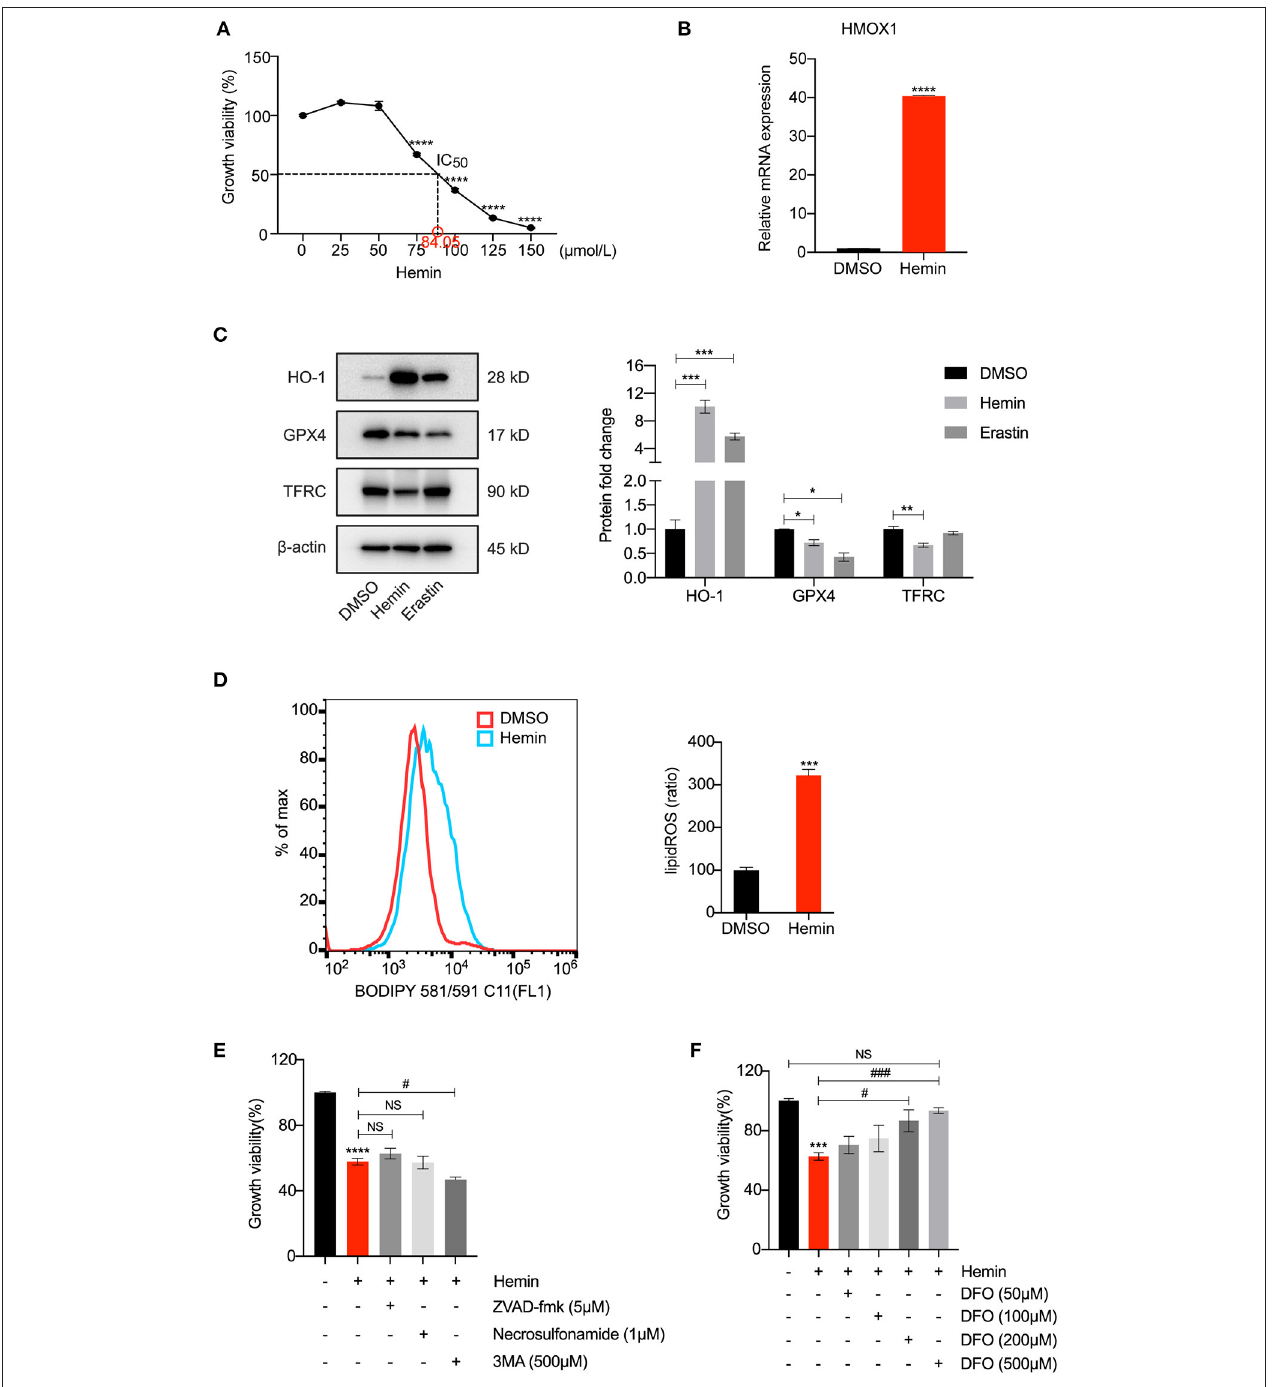
FIGURE 4 | HMOX1 overexpression triggered by hemin leads to ferroptosis of HASMCs. Growth viability of HASMCs (A) in response to different doses of hemin for 24h. The mRNA content of HMOX1 (B) detected by qRT-PCR after treatment with hemin (85 µ M). Representative western blot images and quantitative analysis results (C) of HO-1, GPX4 and TFRC proteins after treatment with DMSO (as negative control), hemin (85 µ M), and erastin (3 µ M, as positive control). Lipid peroxidation production levels (D) detected by BODIPY 581/591 C11 stain (the ratio of lipid ROS was normalized to the blank group) after treatment with hemin (85 µ M). Growth viability of HASMCs (E) after treatment with hemin (85 µ M) in combination with different kinds of cell death inhibitors of zVAD-fmk (5 µ M), necrosulfonamide (1 µ M) and 3MA (500 µ M) for 24h. Growth viability of HASMCs (F) after treatment with hemin (85 µ M) in combination with different doses of DFO. (The error bars represent standard error of mean from three replicates. NS means no significance, # p < 0.05, ### p < 0.001, * p < 0.05, ** p < 0.01, *** p < 0.001, **** p < 0.0001, compared between the groups by t -test).